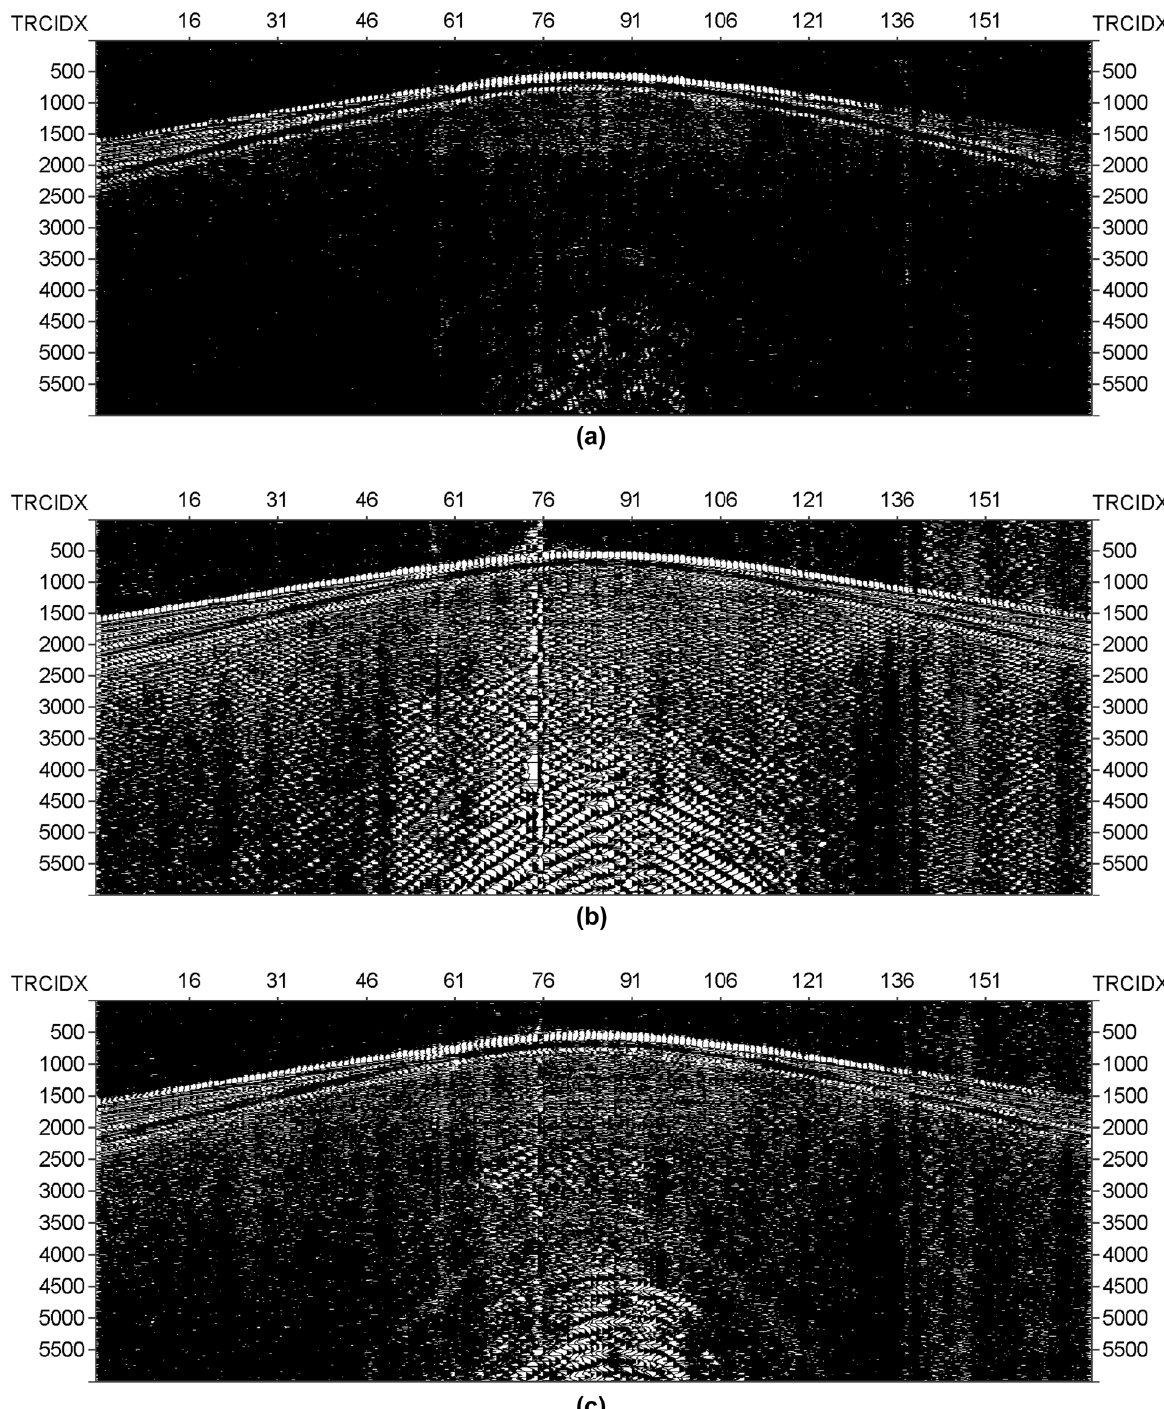
Fig. 15 a Difference section of the TFPF. b Difference section of the PT-TFPF. c Difference section of the